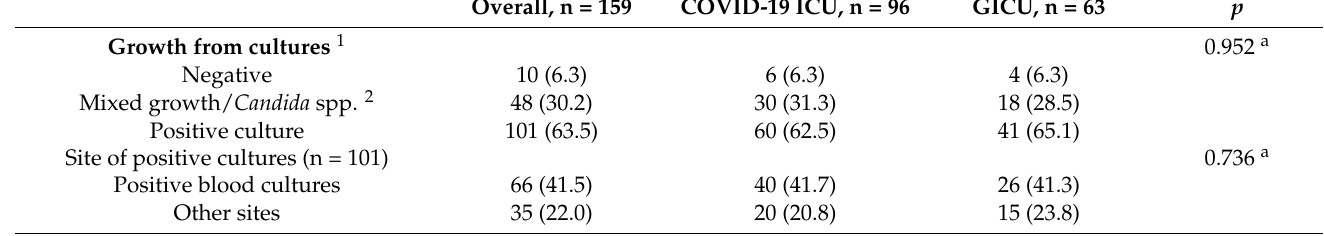
Table 5. Microbiological profiles and organisms isolated prior to carbapenems